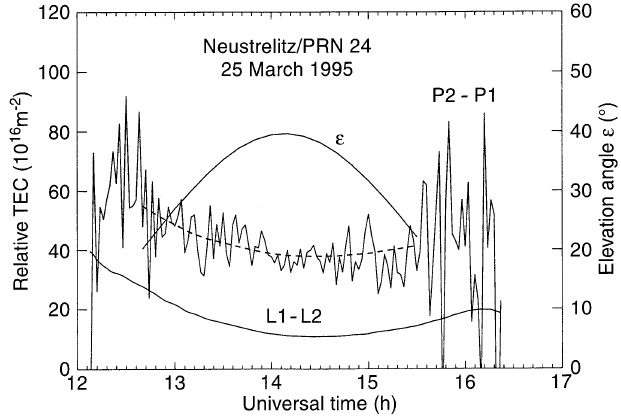
! p (cid:49) ) and carrier phase (L (cid:49) ! L (cid:50) ) compared with the elevation angle ( (cid:101) ). The smooth carrier phases are levelled to the noisy pseudorange phases for elevation angles greater than 20